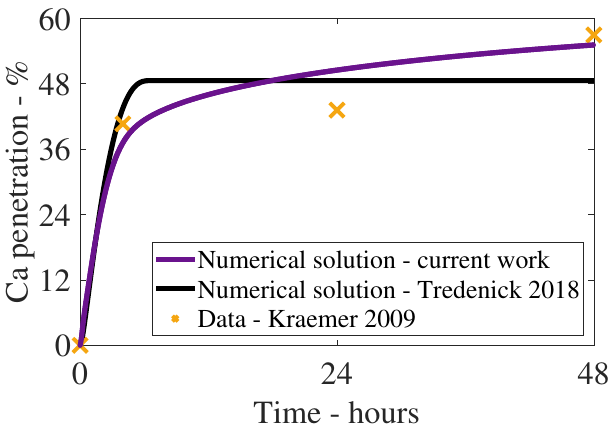
Figure 2. Numerical solution results as percentage penetration with time of the model (purple line) compared to experimental data (orange crosses) for CaCl (1 g/L) and the numerical solution of the model in Tredenick et al. [13] (black line). Parameters are described in Table